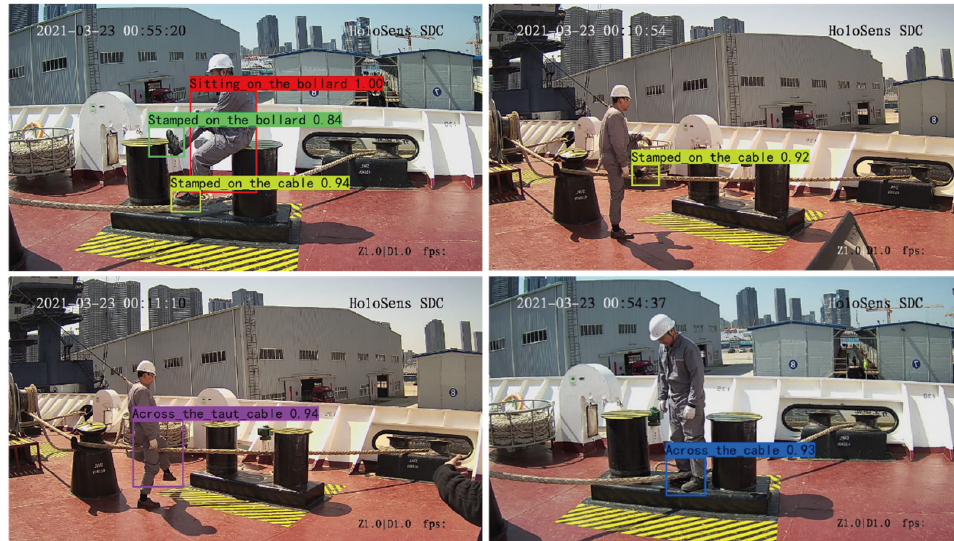
Figure 14. The detection result example.